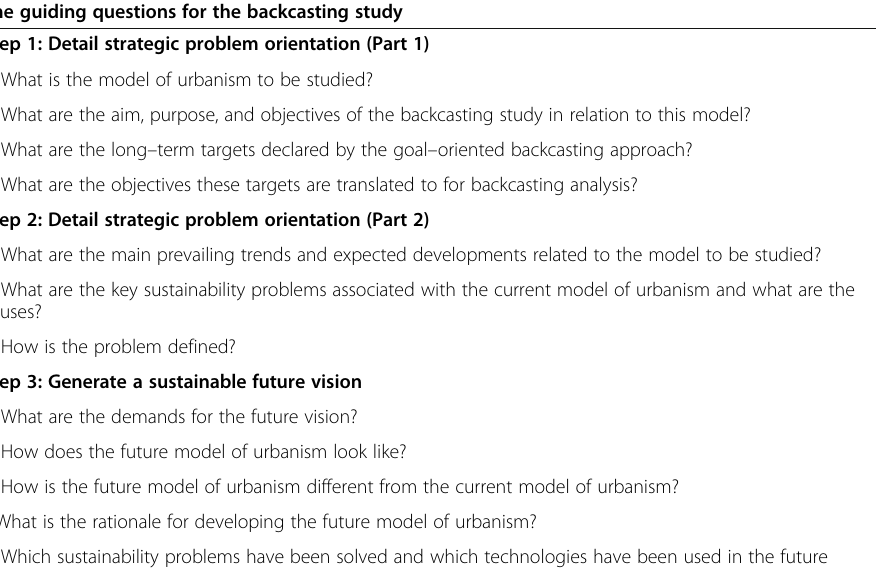
Table 1 The guiding questions for each step in the backcasting-oriented futures study The guiding questions for the backcasting